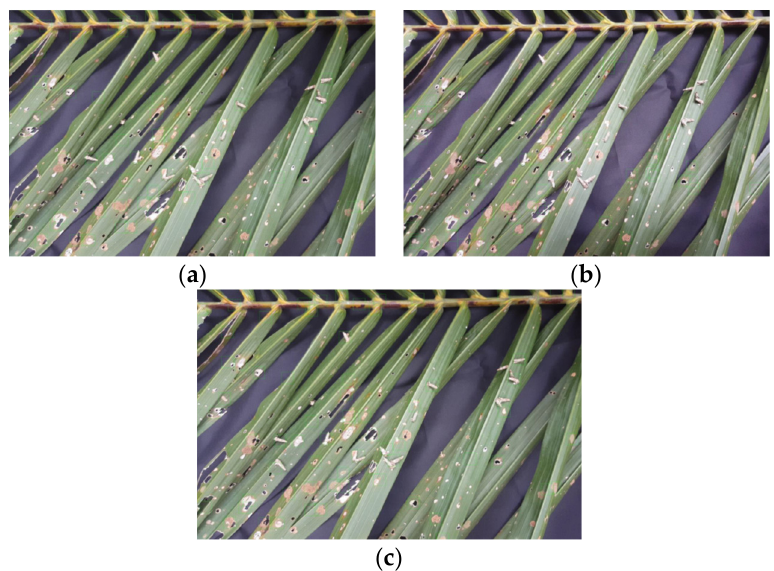
Figure 9. Object detection based on 30 cm camera distance with: ( a ) open, ( b ) closed and ( c ) half open areas.